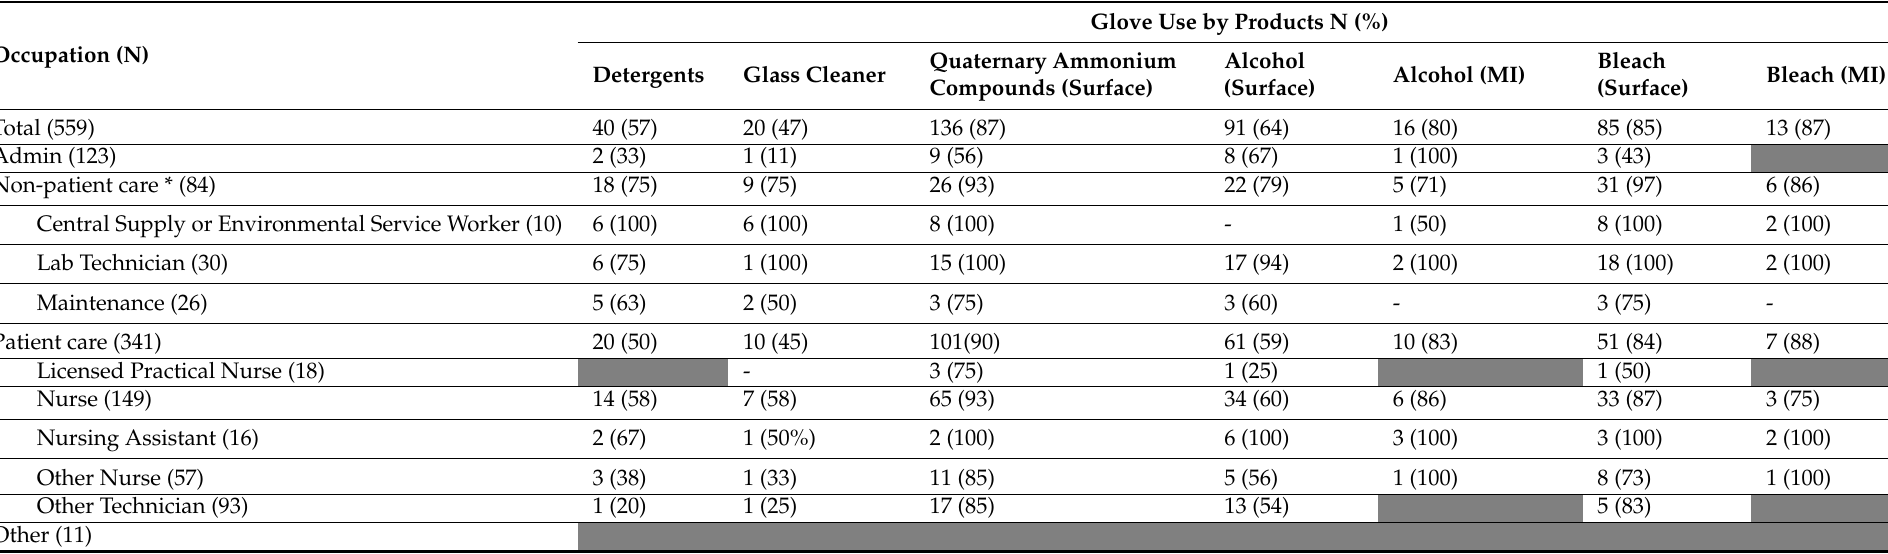
Table 4. Glove use during cleaning product use by combined occupation categories and selected